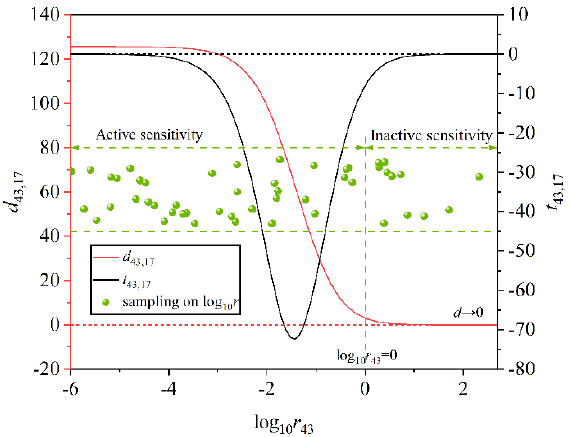
Figure 3. Sensitivity curve (logarithmic axis) and sampling diagram of roadway e 43.